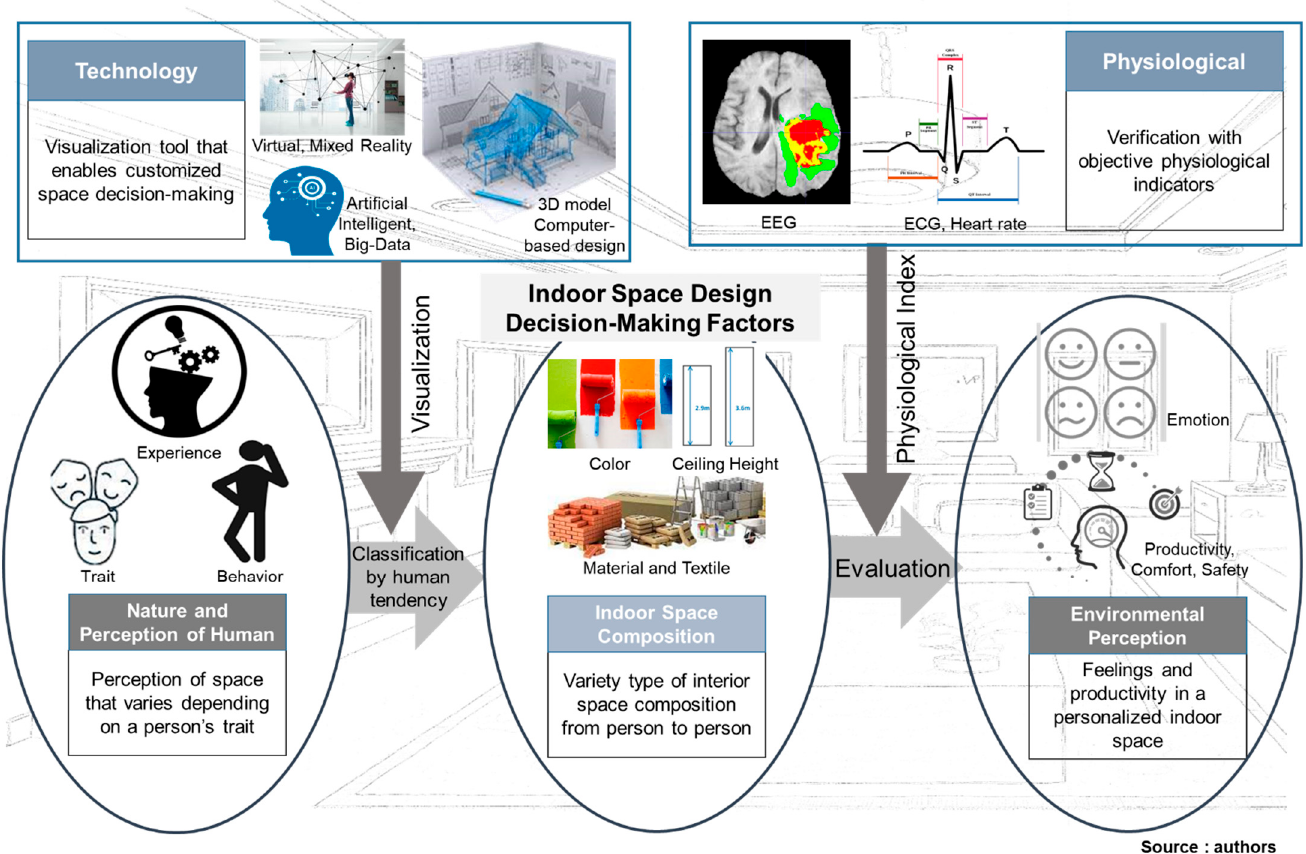
Figure 6. Conceptual framework to support personalized indoor space design decision-making.